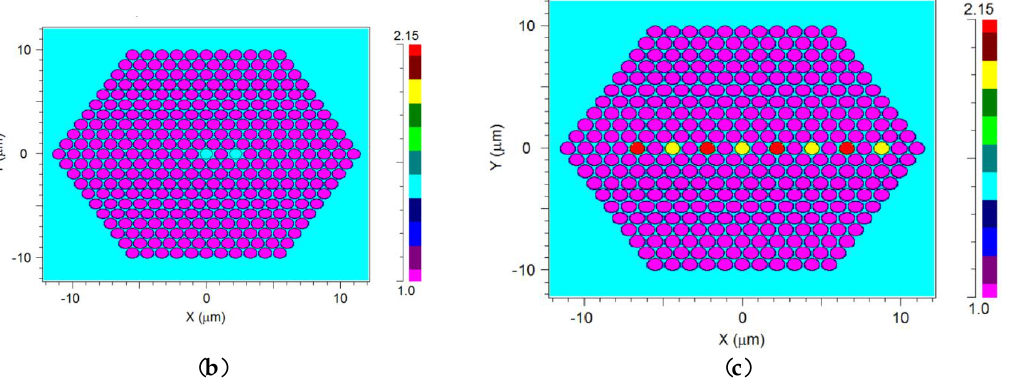
Figure 1. Refractive index profile of the 1 × 8 wavelength demux: ( a ) XZ plane at y = 0 cm. ( b ) XY plane at z = 0 cm. ( c ) XY plane at z = 5 cm.